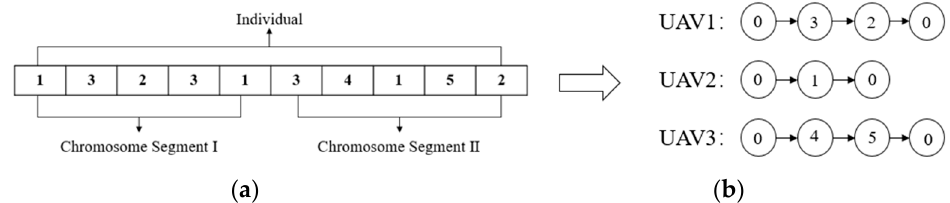
Figure 4. The decoding method. ( a ) An individual for decoding. ( b ) The corresponding decoded